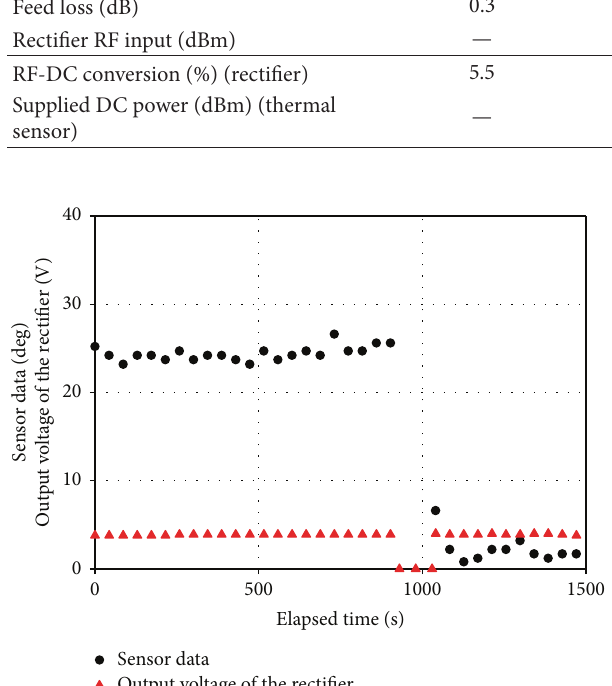
Figure 18: Measured data of the thermal sensor and output voltage of the